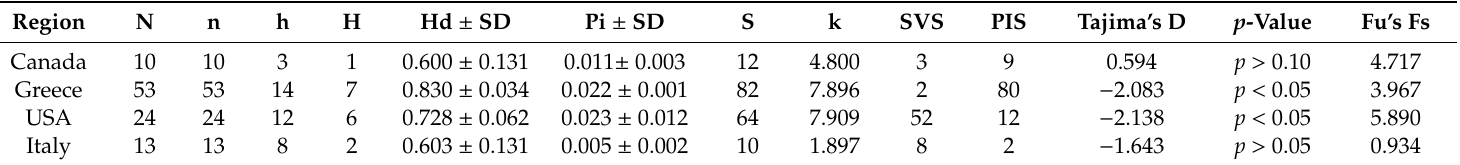
Figure 4. Phylogenetic tree constructed on Internal Transcribed Spacer 1 (ITS1) sequences for Halyomorpha halys using the Maximum Likelihood Tree Build Method, based on the General Time Reversible model. Percentage bootstrap values from 1000 replicates superior to 50% are given at each node. The ITS1 sequences from Valentin et al. (2015) are included [34]. Table 2. Genetic diversity of H. halys populations from Canada, Greece, the US, and Italy, assessed using on Internal Transcribed Spacer 1 (ITS1) sequences. N , number of specimens; n , number of sequences; h, number of haplotypes; H, number of unique haplotypes; Hd, haplotype (gene) diversity; Pi, nucleotide diversity (per site); S, number of variable polymorphic sites; k, average number of nucleotide differences; SVS, singleton variable sites; PIS, parsimony informative sites.